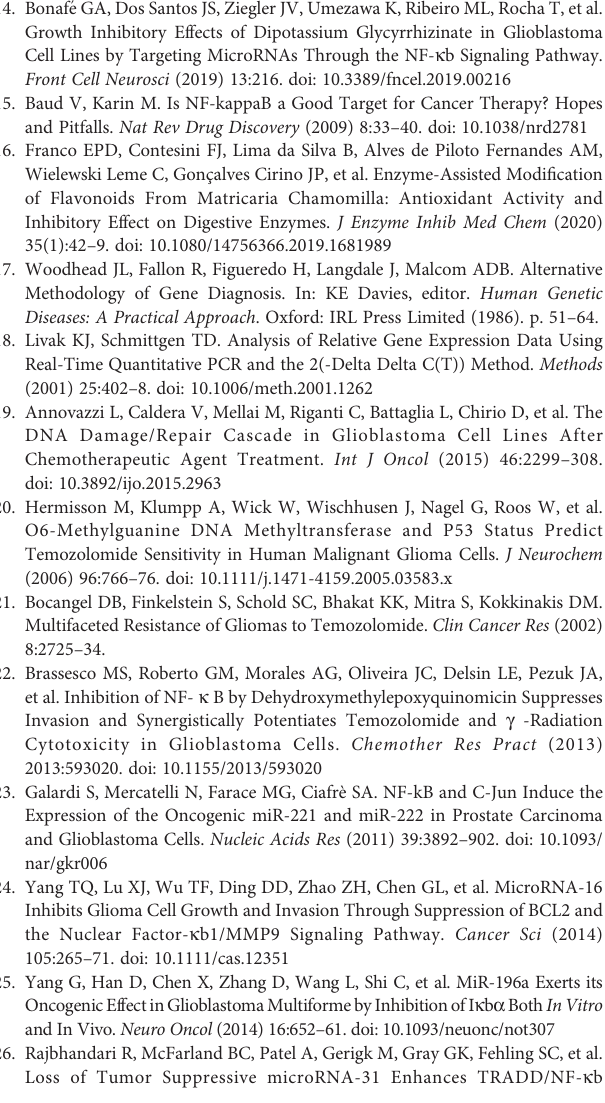
Supplementary Figure 2 | Identi fi cation of microRNAs (miRNAs) with differential expression (DE-miRNAs) in glioblastoma T98G cell line. (A) Scatter plot of 11 DE- miRNAs identi fi ed after comparing dipotassium glycyrrhizinate (DPG)-treated and control T98G cell line (among 91 predicted miRNAs as NF- k B regulator genes). The gray and red dots represent each predicted miRNA. The red dots represent those that presented |fold change, FC ≥ 2|, according to the analysis of the computer program Affymetrix GeneChip ® Command Console ™ . The dots above and below the dashed line represent those up- and downregulated miRNAs after DPG treatment, respectively. (B) Volume graph of the most overexpressed miRNAs among the 11 DE-miRNAs in T98G cell line exposure to DPG. Each gray, blue, and red dot represents one DE-miRNA. The red dots represent those miRNAs that presented both |FC ≥ 2| and increased volume of mRNA detected and quanti fi ed by the Affymetrix GeneChip ® Command Console ™ software. The dots above and below the dashed line represent those up- and downregulated miRNAs after DPG treatment, respectively. Supplementary Table 1 | List of the 91 selected microRNAs predicted as NF- k B modulators and their predicted target genes (above 99%, according to TargetScan database) belonging to the NF- k B signaling